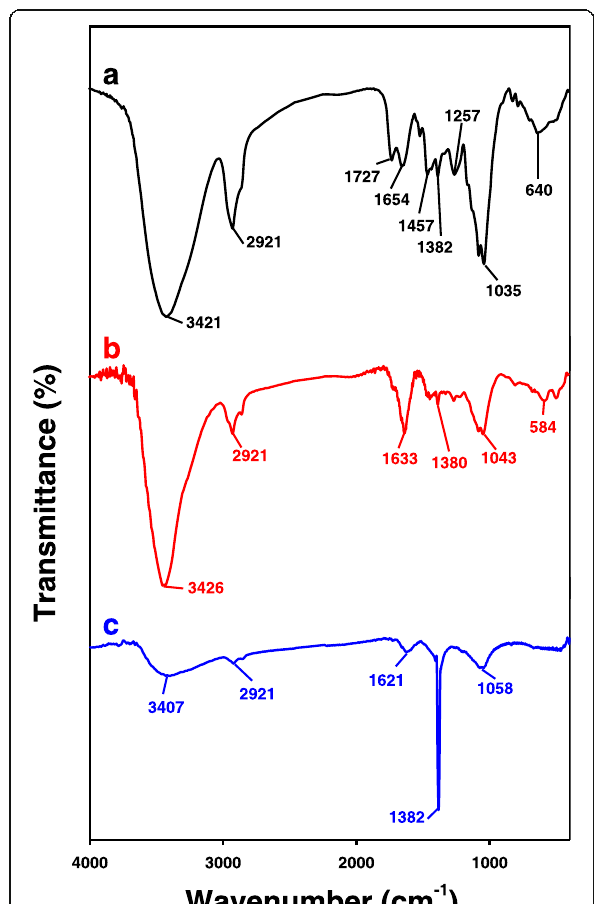
Fig. 9 FT-IR spectra. a PD-enriched fraction. b PD-AuNPs. c PD-AgNPs